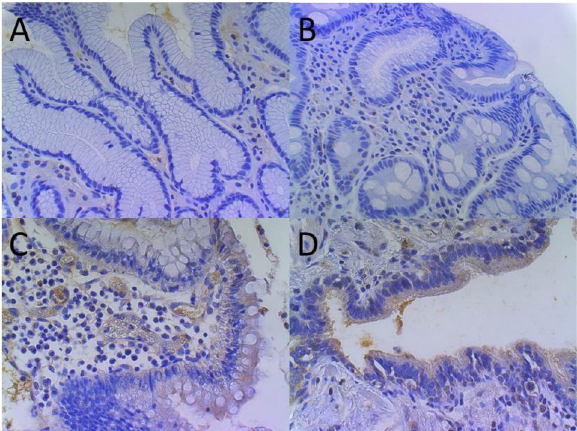
Figure 3. HBD3 immunostaining in H. pylori negative and positive mucosal antrum. HBD3 immunohistochemistry shows no or only a marginal staining in both, H. pylori negative (A) and positive antrum (B). In contrast, HBD3 is clearly found in the cytoplasm of the epithelium in Crohn’s colitis (C) and unspecific bronchiolitis (D).